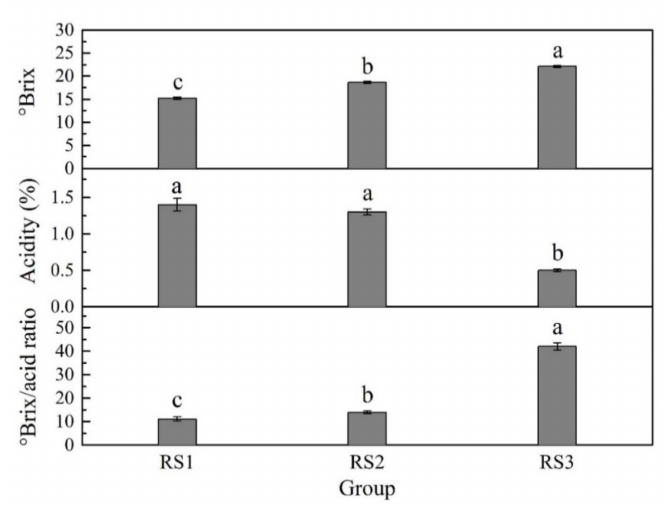
Figure 4. Plot of total sugar content ( top ), titratable acidity ( middle ), and ◦ Brix / acid ratio ( bottom ) of Shine Muscat grape berry extracts at di ff erent ripening stages: RS1, ripening stage 1; RS2, ripening stage 2; and RS3, ripening stage 3. All data represent mean ± SD. Di ff erent letters in the same plot layer indicate a statistically significant di ff erence ( p <